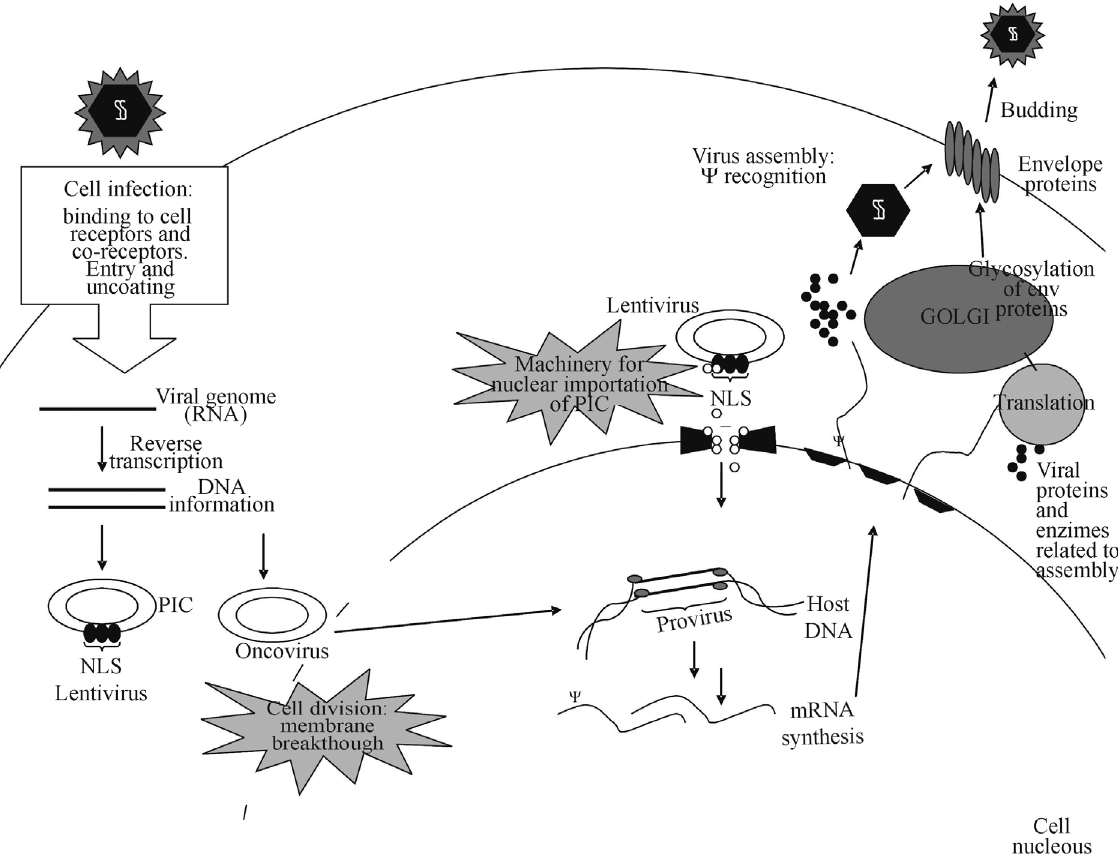
Figure 2 - Schematic diagram of cell infection by retrovirus. Infection starts by binding to cell receptors, which leads to virus entry and uncoating. Retrotranscription occurs in the cytoplasm. Lentiviruses have a nuclear localization signal (NLS) in their preintegration complex (PIC) that interacts with an active nuclear importation machinery dependent on viral and host factors. Oncoviruses do not present this system, and thus depend on membrane breakthrough to access the nucleus. In the nucleus, proviruses will integrate into the host DNA genome. Viral assembly occurs in the cytoplasm, and vi- ruses are liberated from the infected cell by